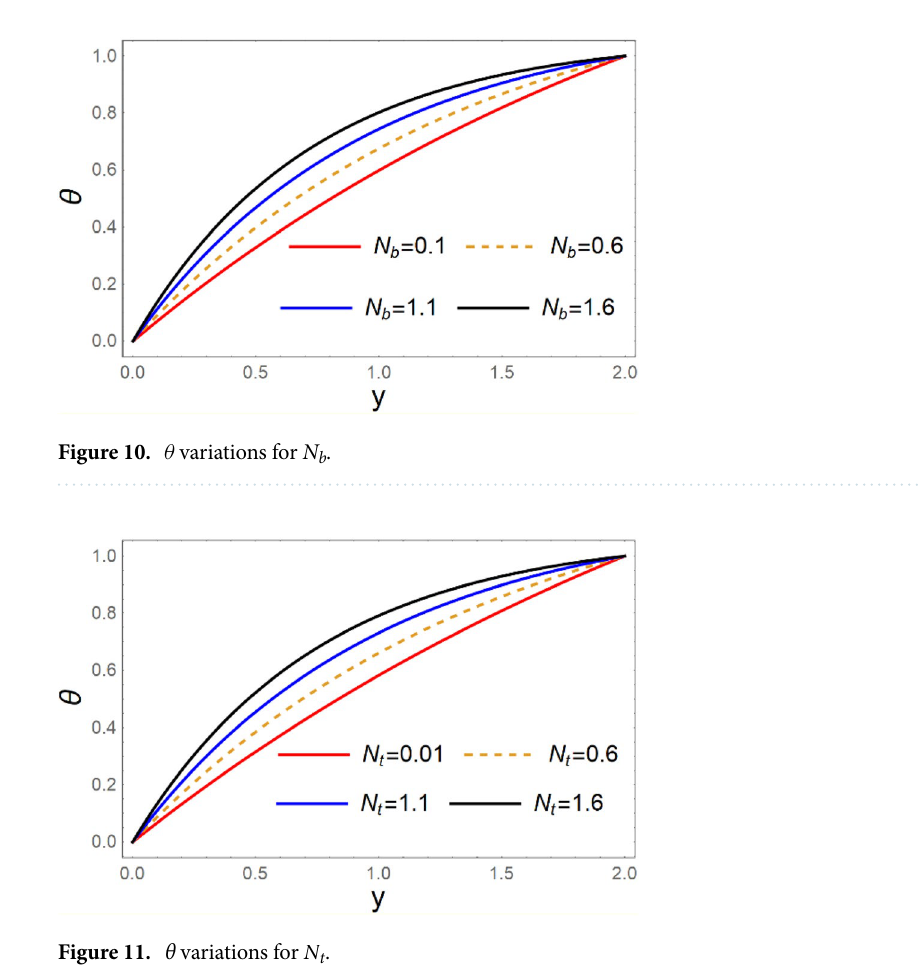
Figure 11. θ variations for N t .